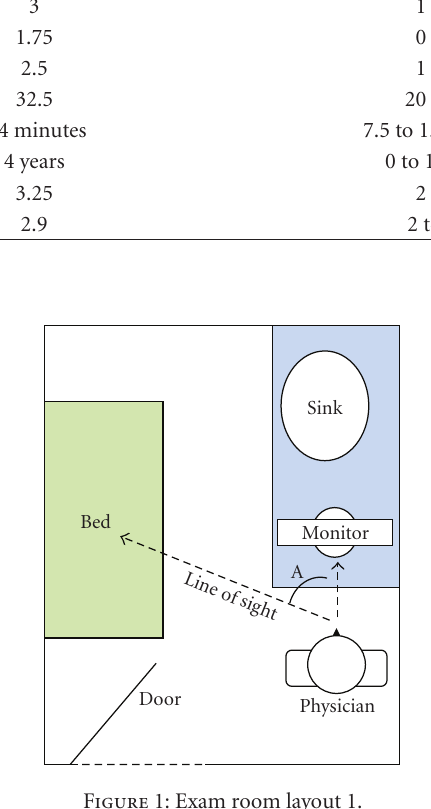
Figure 1: Exam room layout